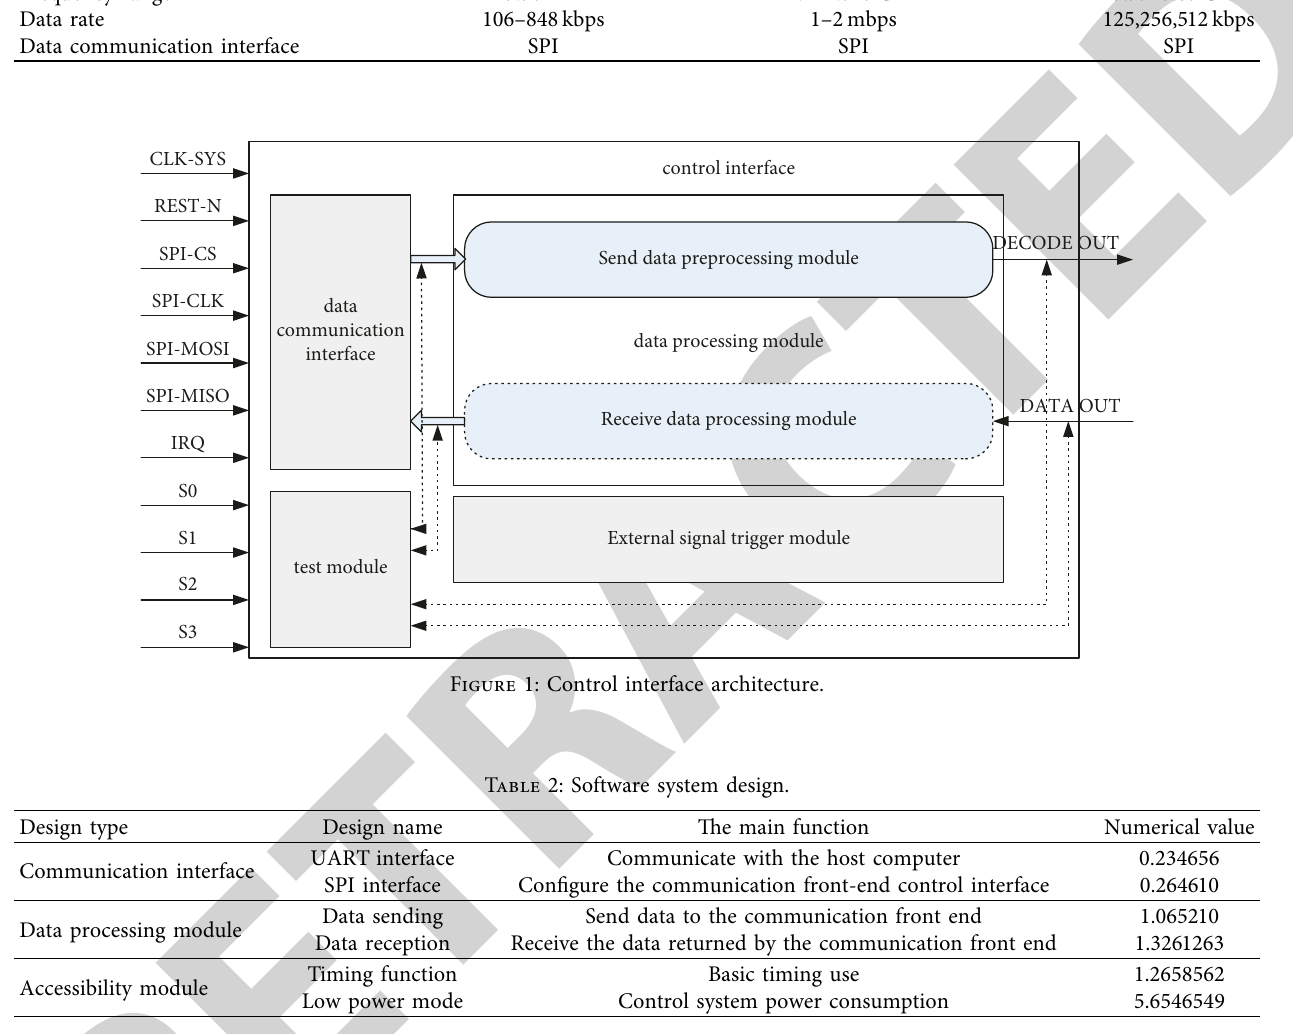
Table 2: Software system